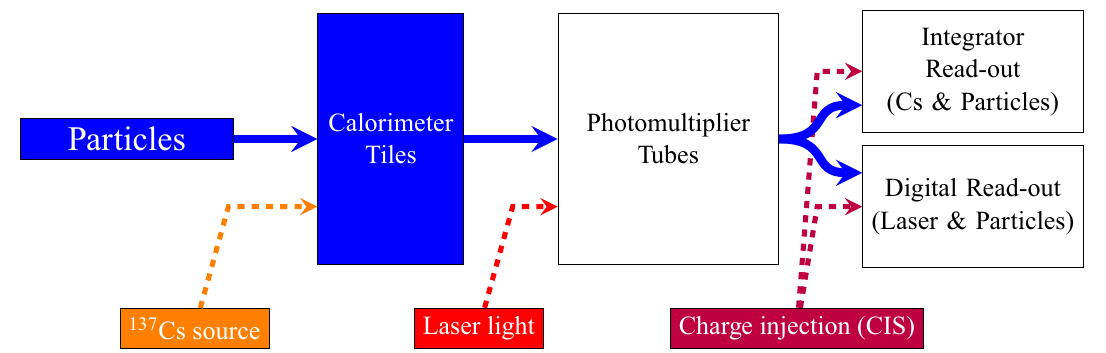
Fig. 13 The signal paths for each of the three calibration systems used by the TileCal. The physics signal is denoted by the thick solid line and the path taken by each of the calibration systems is shown with dashed